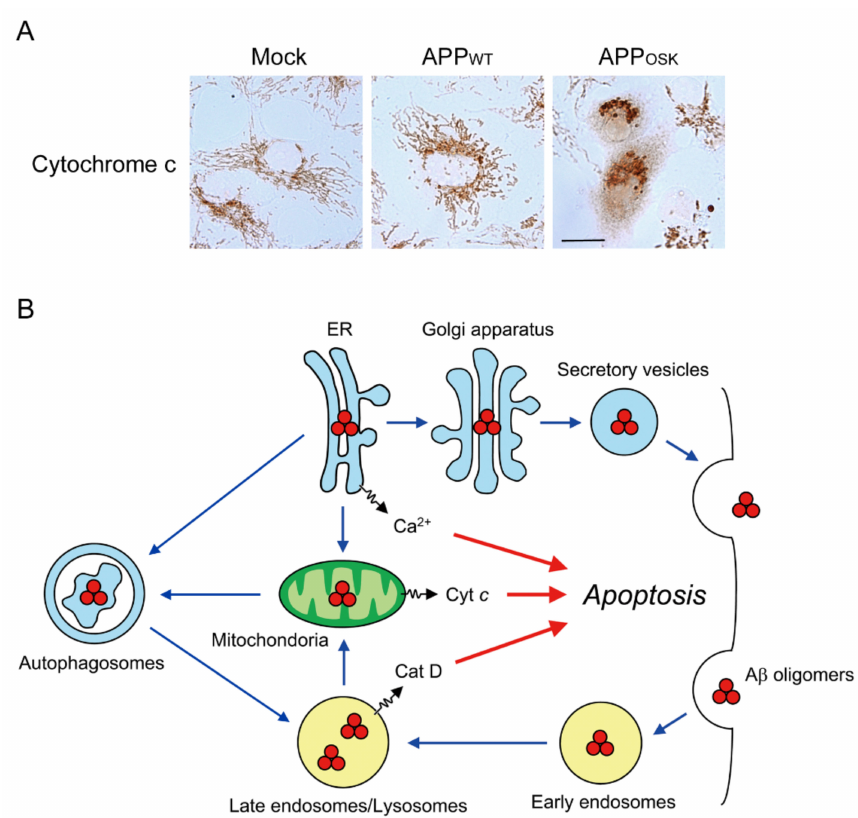
Figure 4. Cytotoxic e ff ects of the Osaka mutation. ( A ) Disruption of mitochondria network by the Osaka mutation. Cytochrome c release from the mitochondria into the cytoplasm was detected in cells expressing the Osaka mutation. Scale bar = 20 µ m. ( B ) Proposed mechanism underlying intracellular A β oligomer-induced cell death. Accumulation of A β oligomers caused ER stress, endosomal / lysosomal damage, and mitochondrial dysfunction, all of which eventually lead to apoptosis (red arrow). Blue arrows indicate the intracellular transport pathways of A β